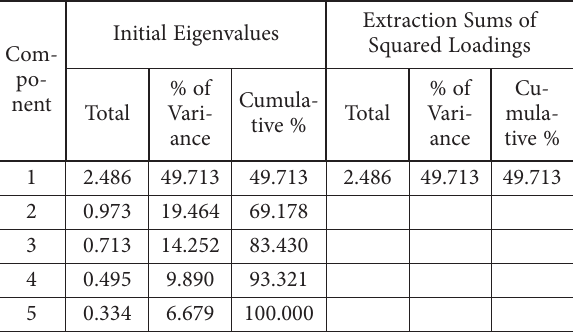
Table 6a. Total explained variance of the macro-nutrient data